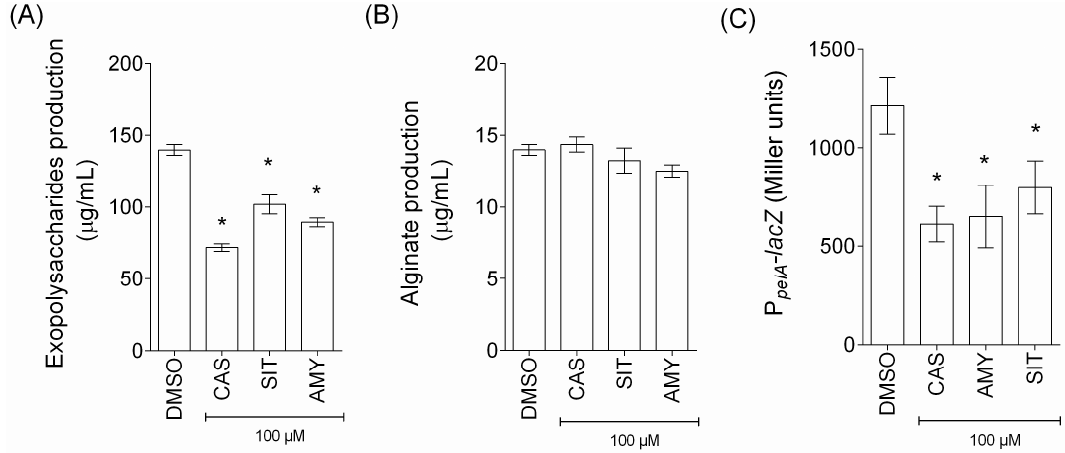
Figure 11. Effect of cassipourol, β -sitosterol and α -amyrin on extracellular polysaccharides production by P. aeruginosa PAO1. ( A ) Quantification of total extracellular polysaccharides: The cell density of the bacteria was assessed at 600 nm and extracellular polysaccharides production was measured using Phenol-Sulfuric Acid method and expressed in µg/mL with glucose as standard; ( B ) Quantification of alginate: The cell density of the bacteria was assessed at 600 nm and alginate production was measured using carbazole method and expressed in µg/mL with sodium alginate as standard; and ( C ) Effect of cassipourol, β -sitosterol and α -amyrin on the expression of pelA gene: Gene expression was measured as the β -galactosidase activity of the lacZ gene fusions and expressed in Miller units. Each compound was tested at 100 µM. Error bars represent the standard errors of the means; all experiments were performed in quintuplicate with three independent assays and asterisks indicate samples that are significantly different from the DMSO (One-way ANOVA followed by Dunnett’s test of multiple comparisons; p ≤ 0.01).